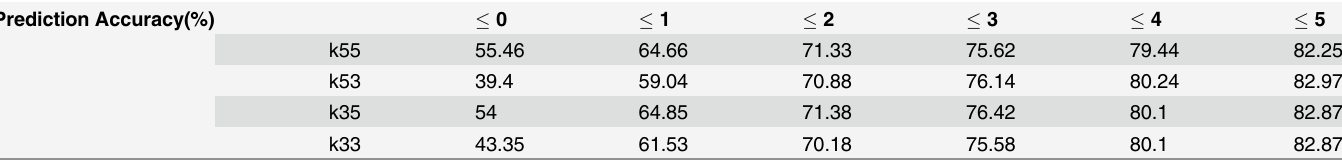
Table 1. End Absolute Error (EAE) in nts. Prediction